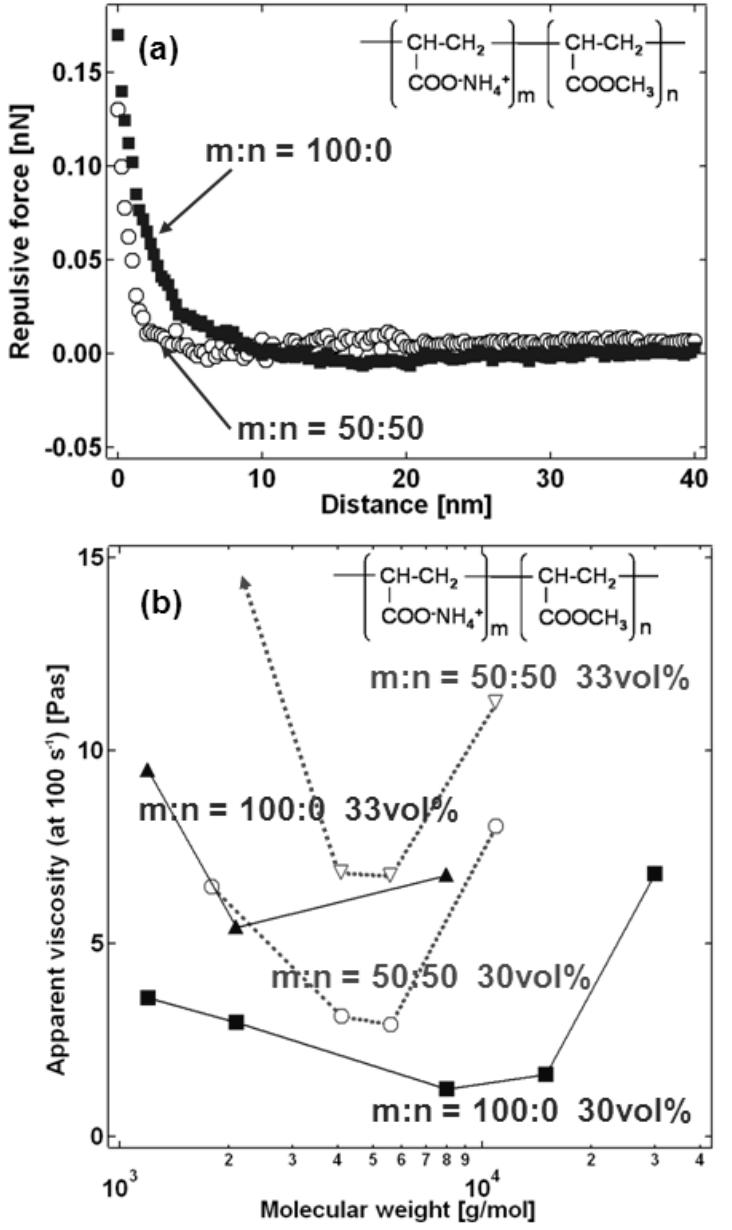
Fig. 5 (a) Force curves measured between TiO 2 nanoparticles treated by anionic polymer dispersants and the (b) apparent viscos- ity of corresponding TiO 2 /water